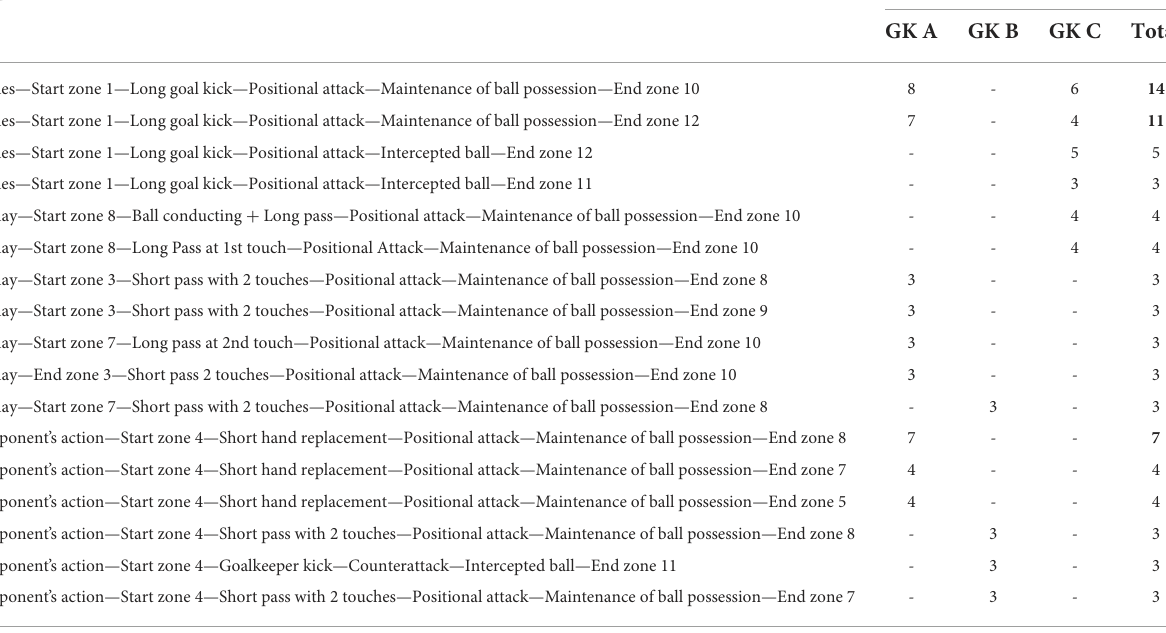
TABLE 5 T- patterns related to the GK offensive actions. T- pattern